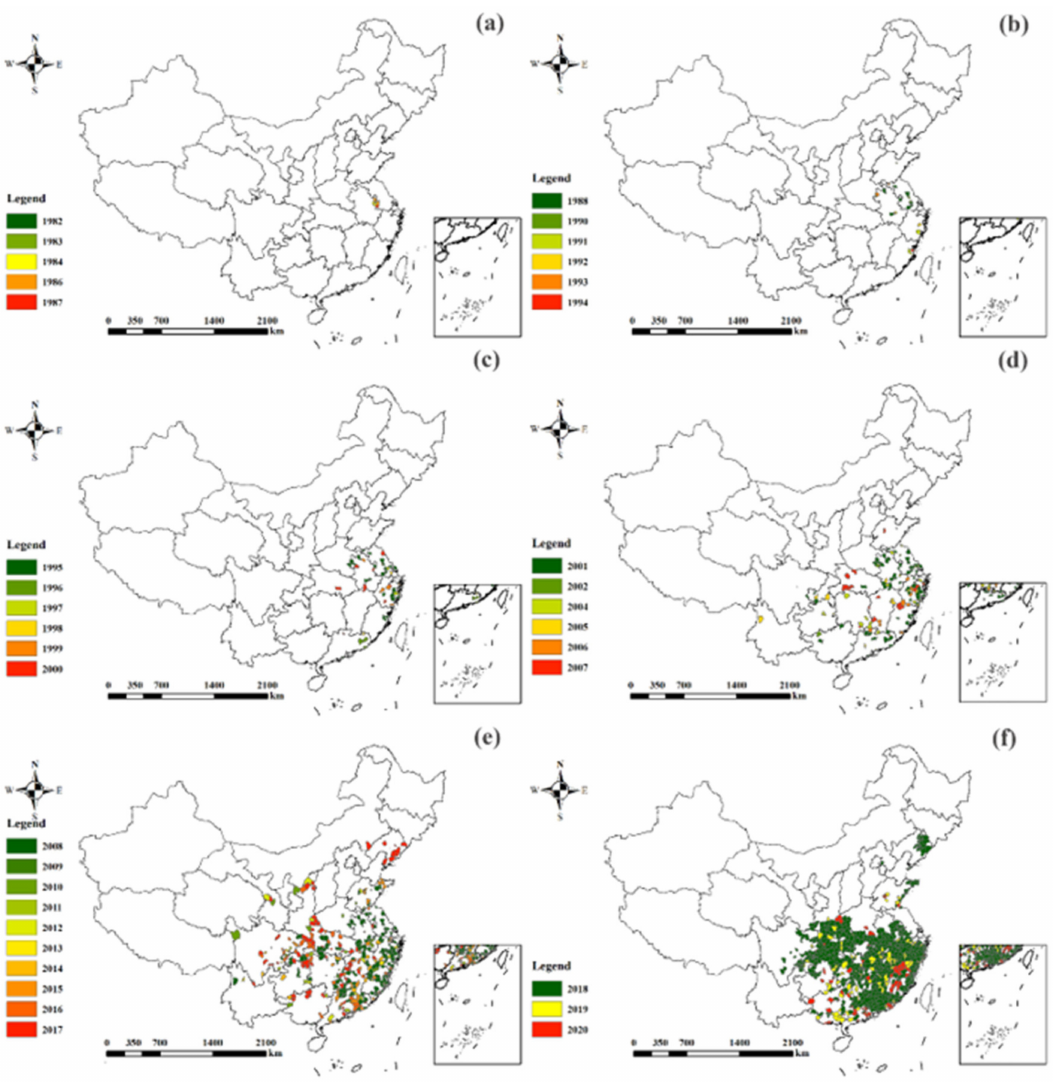
Figure 3. Spatial spread of PWD-damaged forests in China in the six stages between 1982 and 2020 (the first year in each figure denotes the current distribution of PWD-damaged forests in this year (green area), and the areas in the following years indicate the increased PWD-damaged forest areas) ( a ) 1982–1987; ( b ) 1988–1994; ( c ) 1995–2000; ( d ) 2001–2007; ( e ) 2008–2017; ( f )